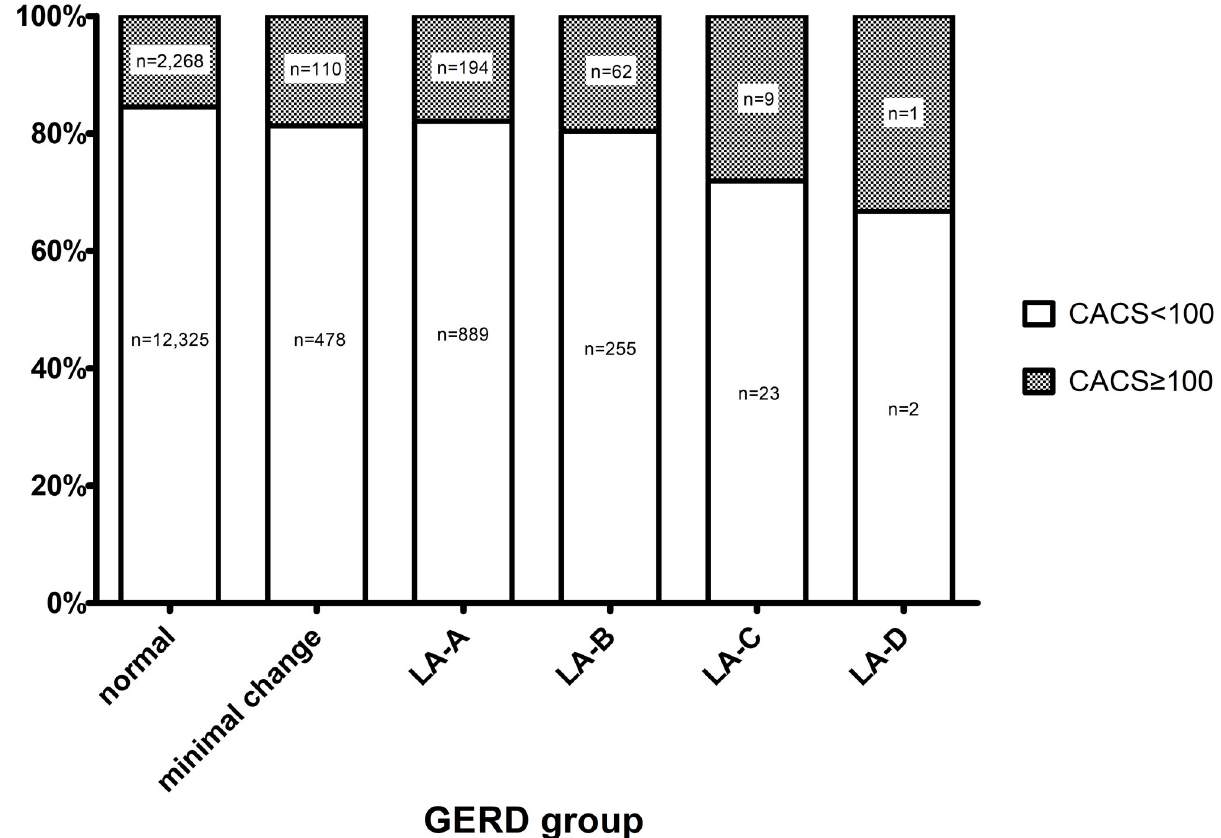
Fig 1. Coronary artery calcium scores (CACS) according to the severity of gastroesophageal reflux disease (GERD). The prevalence of high CACS ( � 100) was increased significantly as the severity of GERD increased ( p =